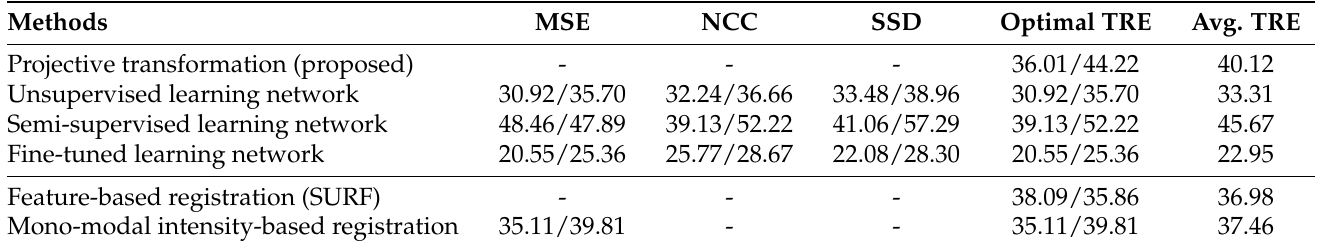
Table 3. Measured TRE values for the proposed registration networks and baseline registration methods (NCC: normalized cross-correlation; SSD: sum of squared differences; left metric number: background; right metric number: